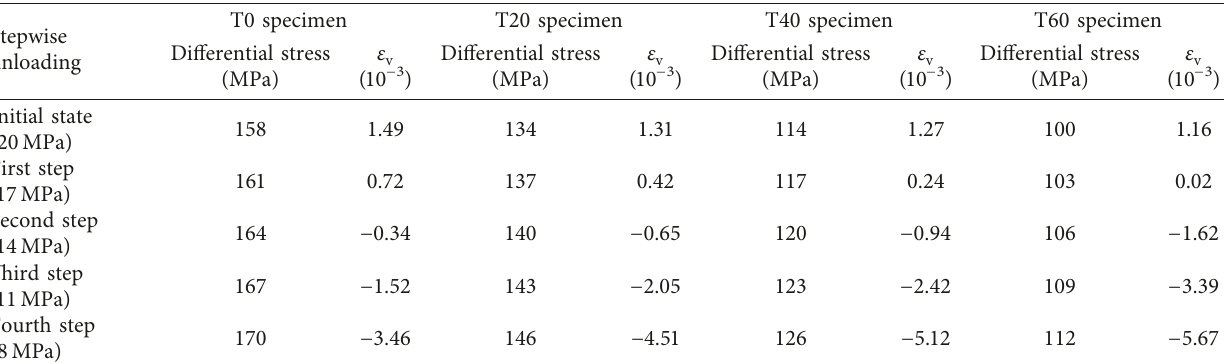
Figure 11: Volume creep-time Table 4: The variation of volume creep.